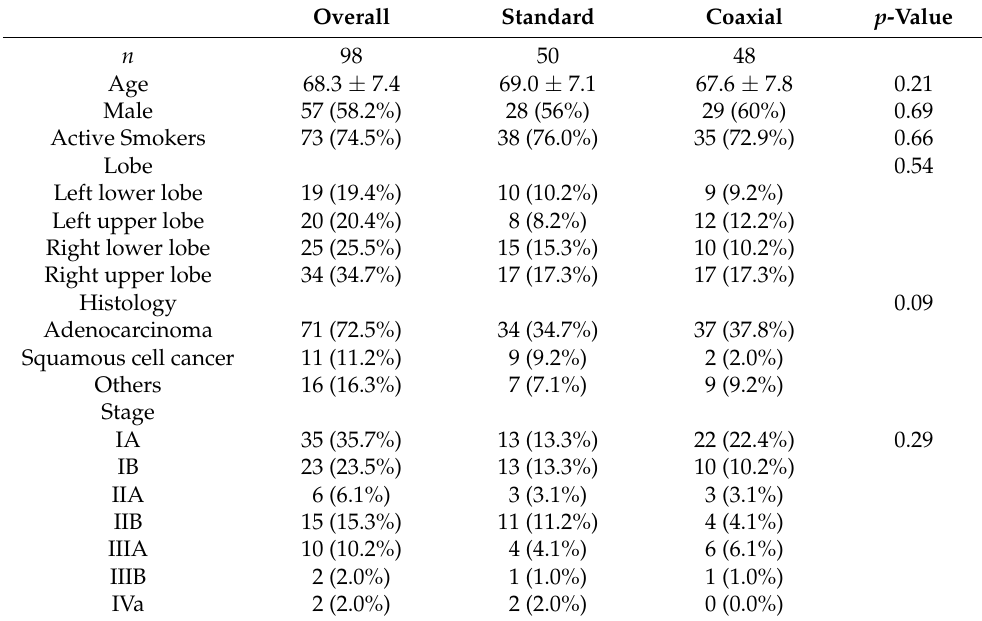
Table 1. Baseline characteristics and operative data. Data are n (%) or mean ± standard